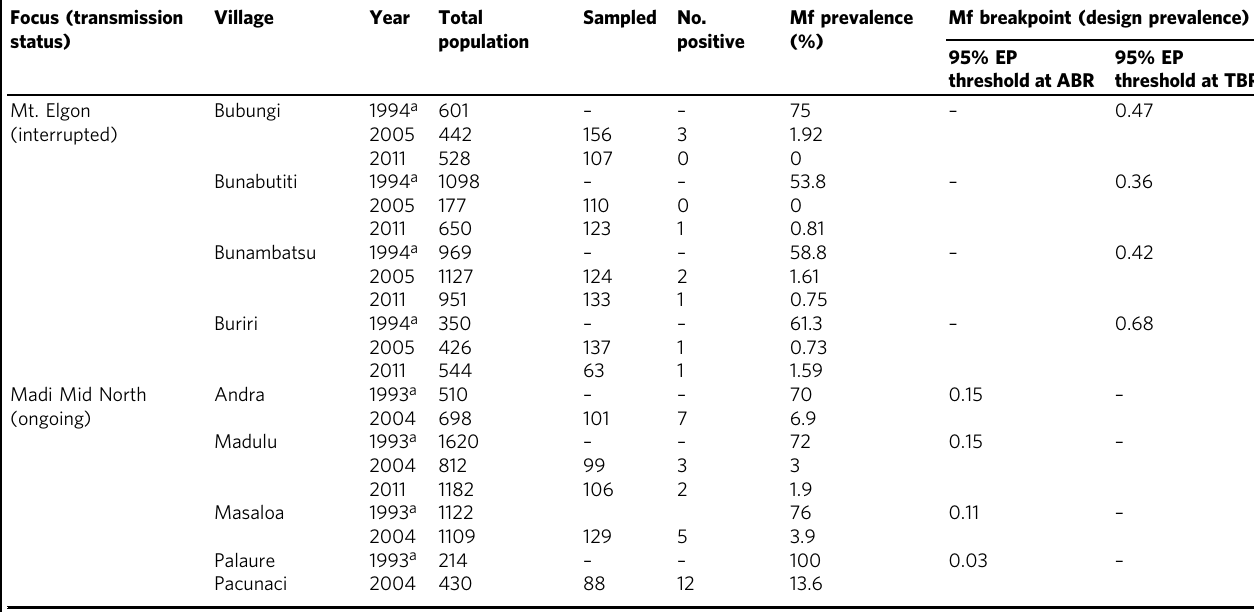
Table 1 Onchocerciasis survey data for Ugandan villages and model-predicted Mf prevalence thresholds at village-speci fi c ABR and TBR Focus (transmission